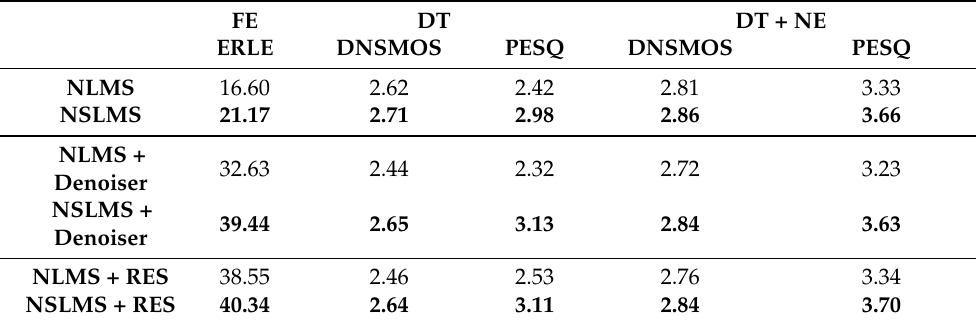
Table 1. Performance comparison of the different systems. FE stands for far-end-only scenarios, NE stands for near-end-only scenarios, and DT stands for double-talk scenarios. Results in bold represent the best result in the column and row group (where row groups are separated with bold